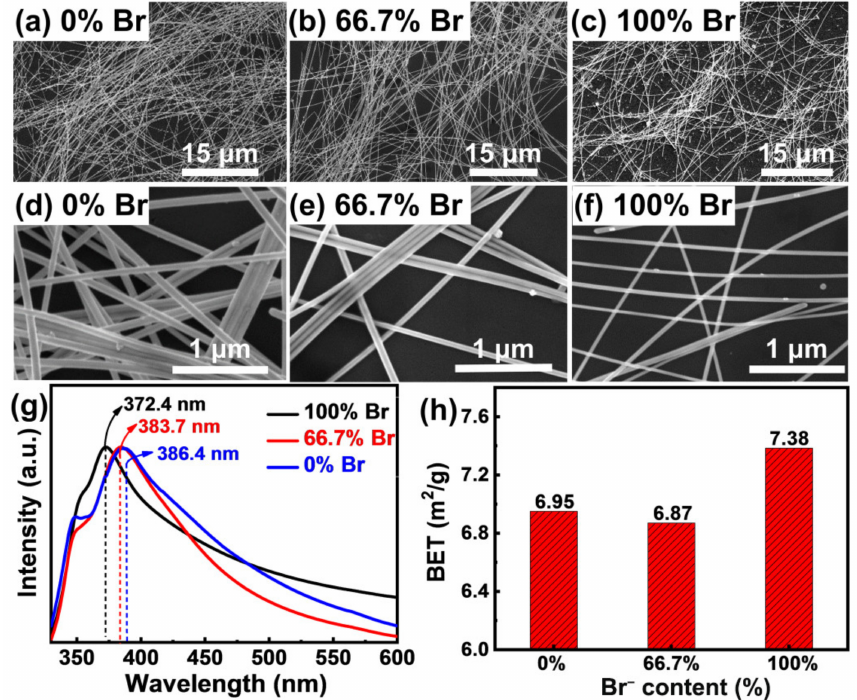
Figure 3. ( a – f ) SEM images of purified samples of AgNWs obtained with different Br content. ( g ) UV–visible extinction spectra of the final products. ( h ) The specific surface area of AgNWs. The influence of I − on the growth of AgNWs is also explored in the mixture system of Cl − and I − . In the I − ions dominated conditions (50–100% I − ), Ag nanoparticles are the only products without the generation of AgNWs. The generation of Ag nanorods (only ~0.74 µ m) with an extremely small aspect ratio of 15.1 is observed only when the I − is